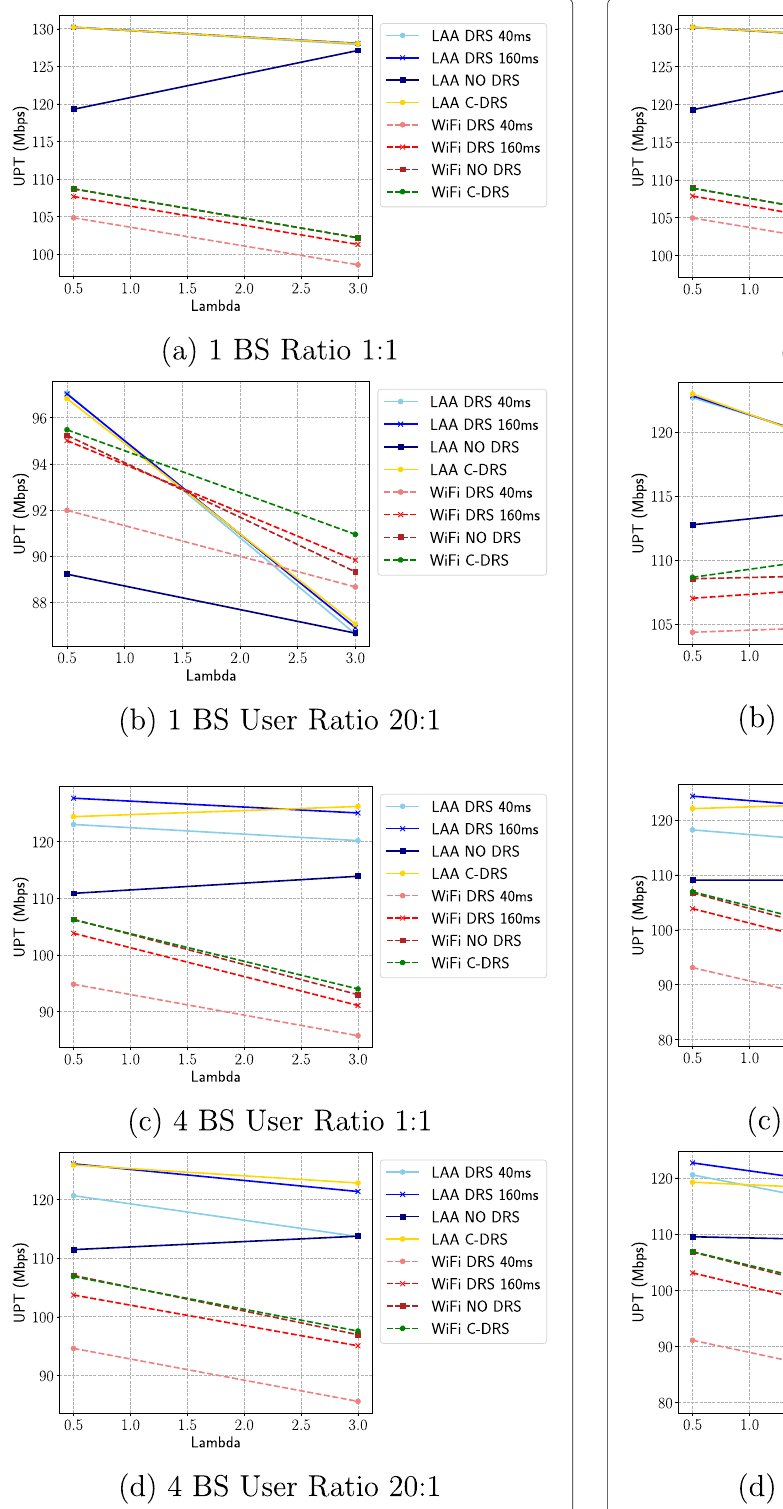
Fig. 8 Static scenario density UPT results Fig. 9 Scenario density UPT results (ped.